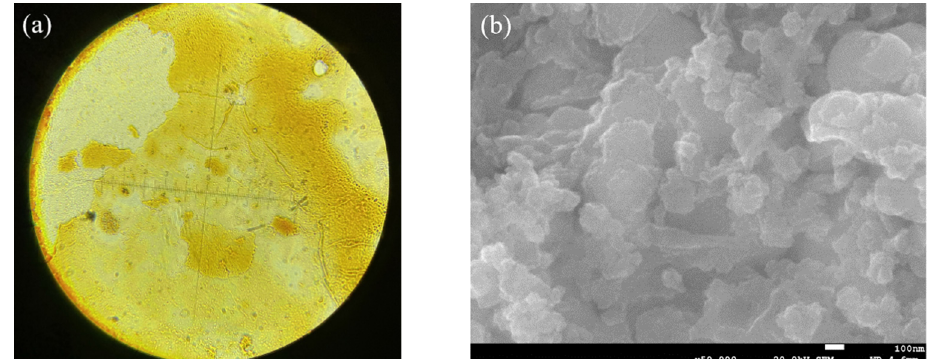
Figure 3. Surface morphology of Fe 3 O 4 nanosheets. ( a ) Fe 3 O 4 nanosheets under a 25 × 10 optical microscope and ( b ) the SEM image of Fe 3 O 4 at 100 nm scale.